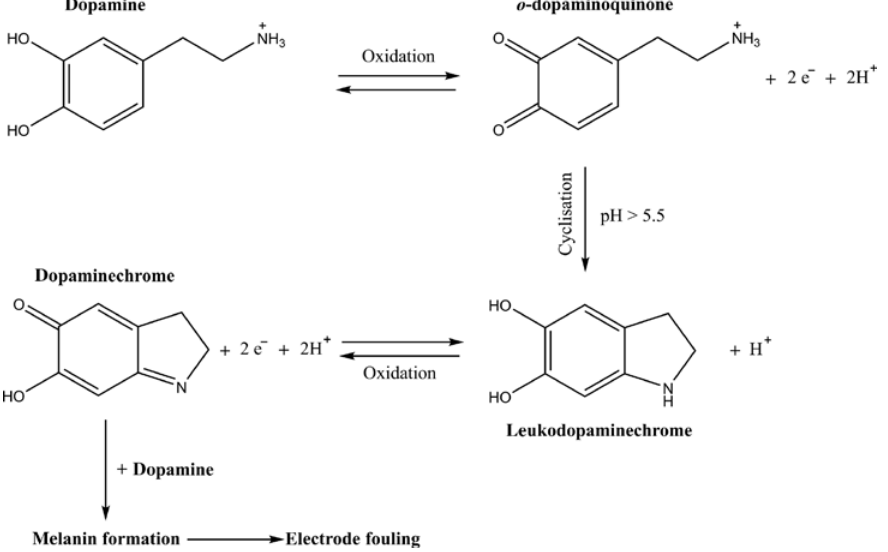
Scheme 1: A mechanism proposed by Harreither et al. (2013) for electrode fouling during the electrochemical oxidation of dopamine in aqueous